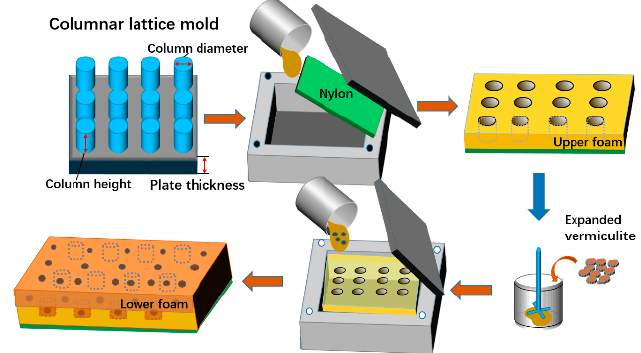
Figure 1. Schematic diagram for the preparation of bionic composites. Table 1. Specifications of bionic composites.